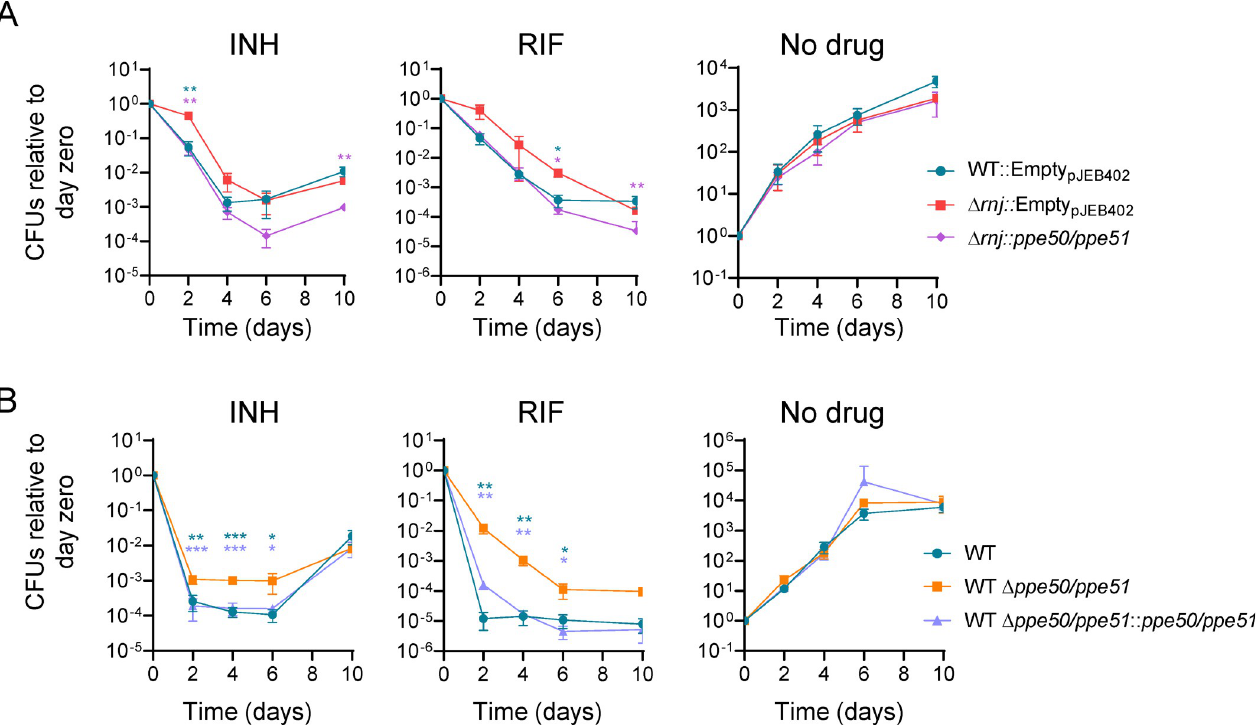
Fig 6. Downregulation of ppe50-ppe51 is required for the drug tolerance phenotype of Δ rnj Mtb, and deletion of ppe50-ppe51 is sufficient to induce drug tolerance in a WT background. Time-kill curves in the presence of RIF (0.6 μ g/mL) or INH (2.4 μ g/mL) in Mtb mc 2 6230 strains. A. ppe50-ppe51 was ectopically expressed from a strong constitutive promoter in the Δ rnj strain. � p < 0.05, �� p < 0.01, two-way ANOVA. Blue stars: comparison of WT:: Empty pJEB402 to Δ rnj ::Empty pJEB402 . Magenta stars: comparison of Δ rnj :: ppe50/ppe51 to Δ rnj ::Empty pJEB402 . B. ppe50-ppe51 was deleted from the WT strain and then ectopically expressed from a strong constitutive promoter. � p < 0.05, �� p < 0.01 ��� p < 0.001, two-way ANOVA. Blue stars: comparison of WT to WT Δ ppe50-ppe51 . Lavender stars: comparison of WT Δ ppe50/ppe51 :: ppe50/ppe51 to WT Δ ppe50-ppe51 . FDR 0.05 (Benjamini and Hochberg) for all